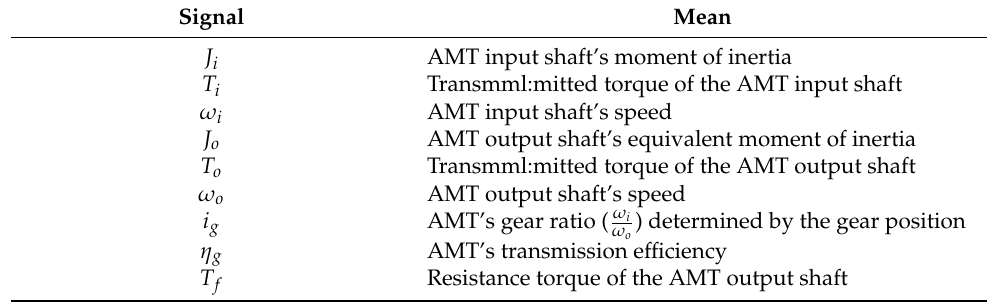
Table 1. Model parameters.